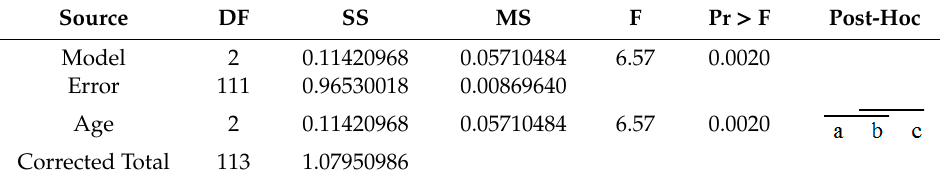
Table 5. Tukey post-hoc test in male participants according to age.